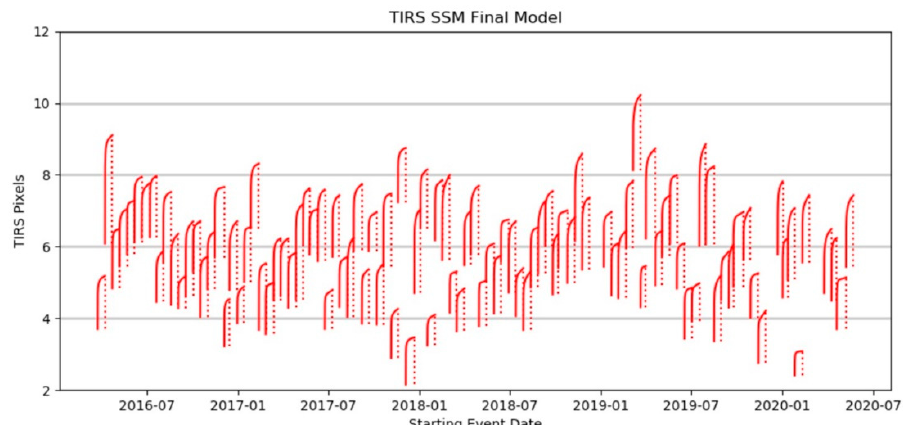
Figure 5. Position of the SSM with respect to its nominal nadir pointing position. SSM models shown are for each event from 1 March 2016 to 11 May 2020. Variability in the starting angular location is evident from the figure. The dotted lines shown represent the end of the event and not any behavior associated with the mirror itself.